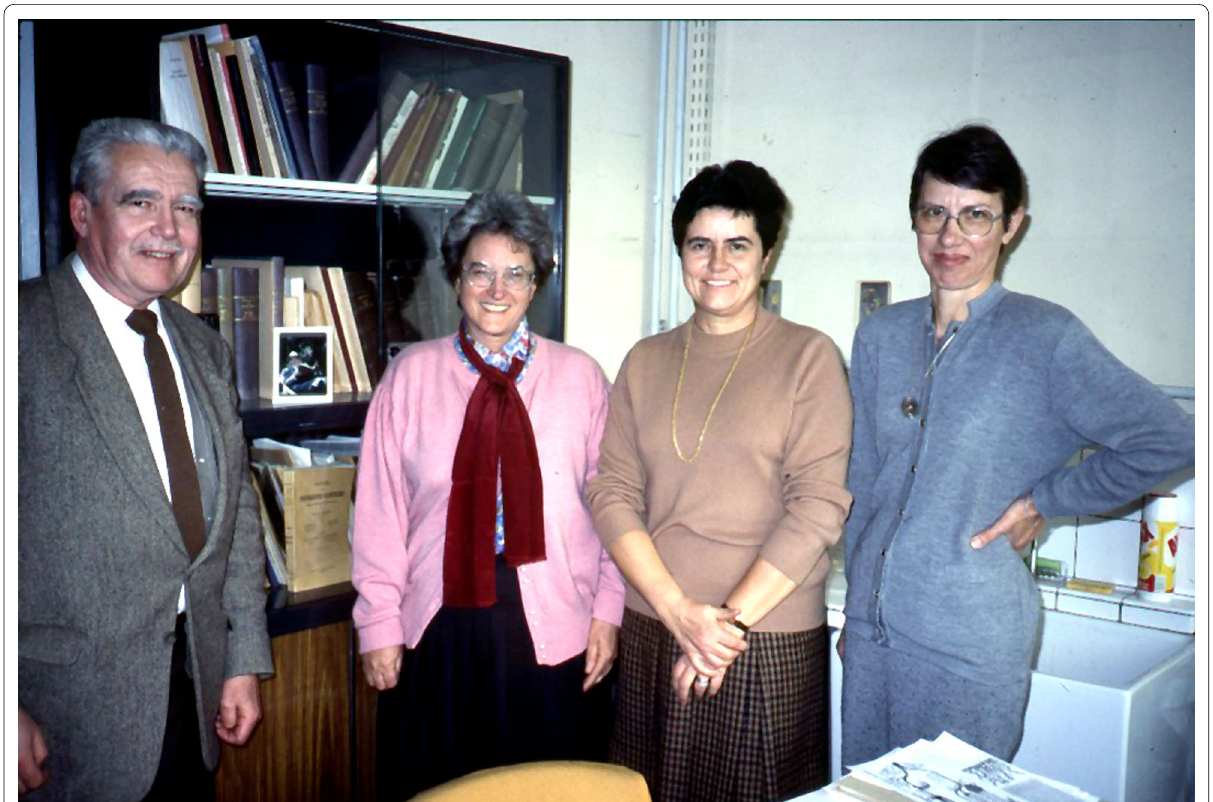
Fig. 17 Chadefaud’s four PhD students ( left to right ): André Bellèmere, Marie-Agnès Letrouit-Galinou, Marie-Claude Janex-Favre, and Agnès Parguey-Leduc; Pierre and Marie Curie University, Paris 1989. Photo: D L